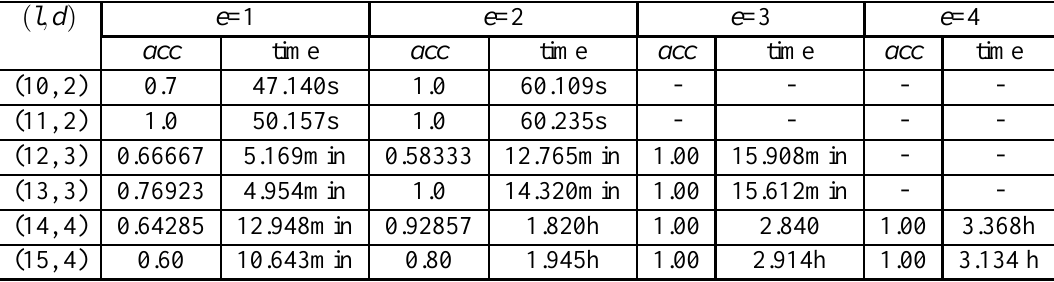
Table 2: The Influence of parameter e on